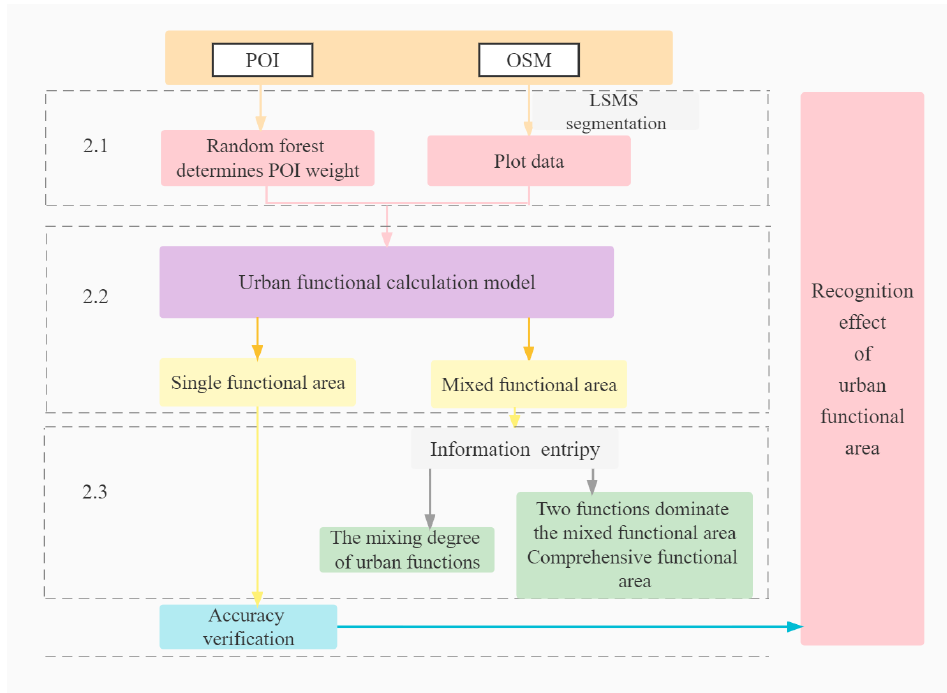
Figure 2. Logical framework